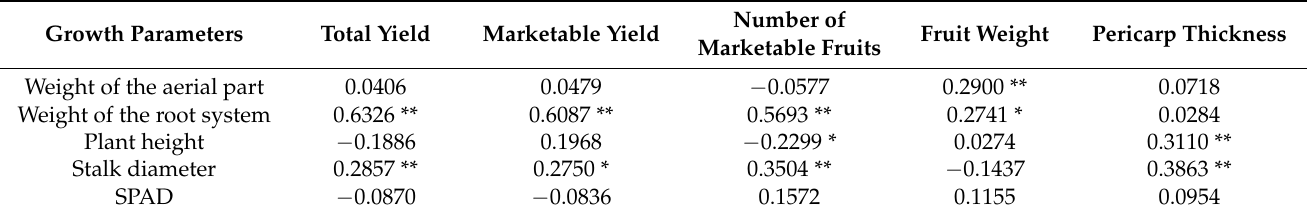
Table 4. Linear correlation coefficients (n = 81) between yield parameters and the quality of sweet pepper, and growth parameters of plants and the value of SPAD